Question: What style of plot is this figure drawn as?
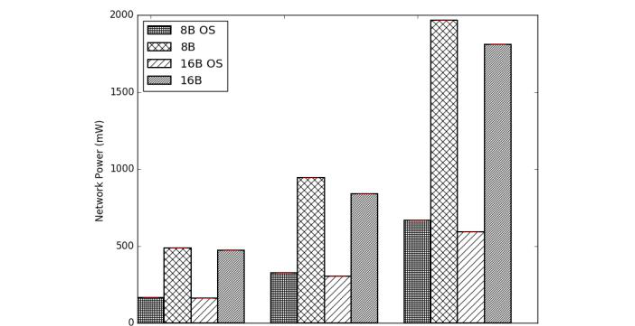
Answer: line